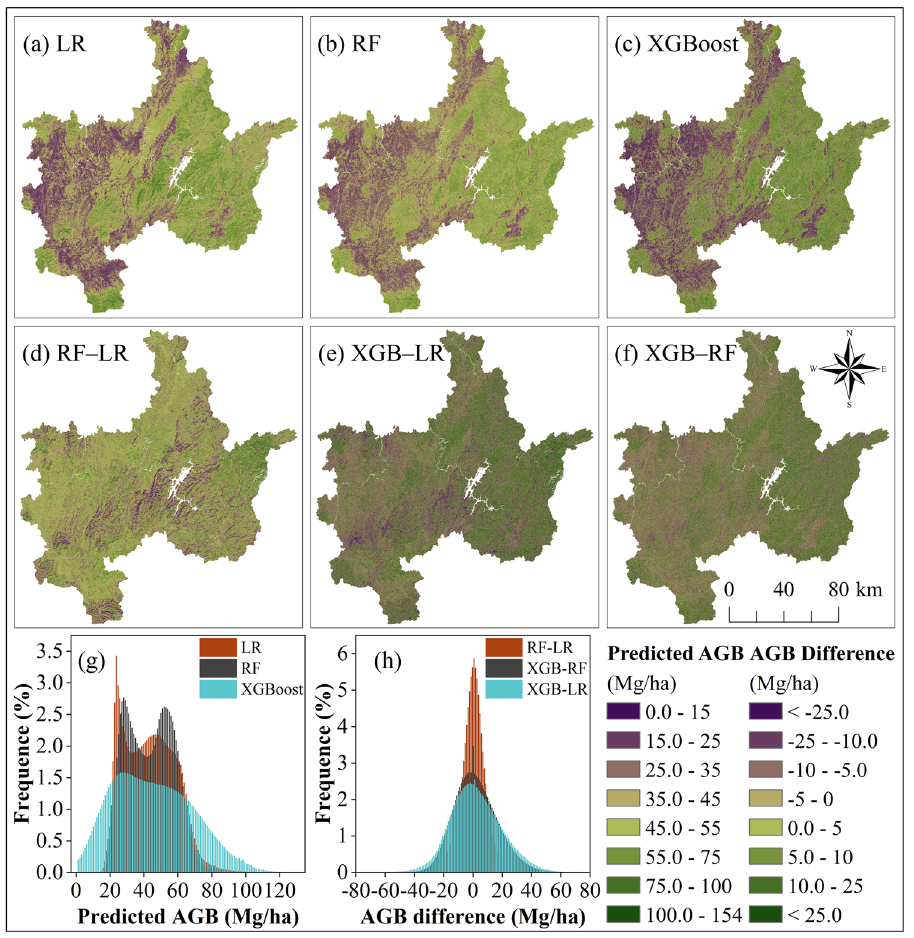
Figure 4. The predicted AGB using ( a ) LR, ( b ) RF and ( c ) XGBoost models with the optimal parameters, including ( d ) the difference between RF and LR (RF ‒ LR), ( e ) the difference between XGBoost and LR (XGBoost ‒ LR), ( f ) the difference between XGBoost and RF (XGBoost ‒ RF), ( g ) the histograms of pixel values frequency of LR, RF and XGBoost models, and ( h ) their